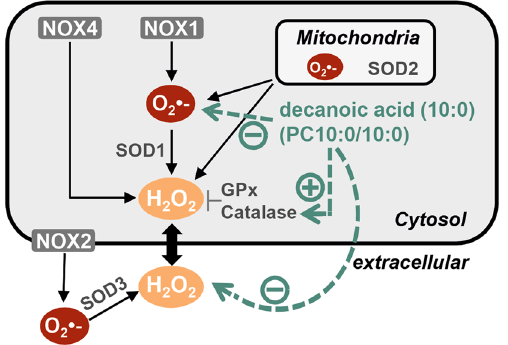
Figure 5. Schematic overview of the cellular generation and detoxification of O 2•− and H 2 O 2 including the observed effects of decanoic acid (10:0). The mitochondrial electron transport chain and NOX activity are the major cellular sources of O 2•− , which is rapidly converted to H 2 O 2 by distinct SODs (mitochondrial SOD2, cytosolic SOD1, extracellular SOD3). In contrast to other NOX isoenzymes generating O 2•− , NOX4 predominatly releases H 2 O 2. H 2 O 2 diffuses across cellular membranes and is intracellularly detoxified by antioxidant enzymes such as GPx and catalase. Decanoic acid (10:0) administered in the form of PC10:0/10:0 reduces the intracellullar ROS level with O 2•− probably representing the major detected ROS species. Additionally, the steady state level of extracellular H 2 O 2 as well as H 2 O 2 release is decreased in cells treated with PC10:0/10:0. The latter effect might be at least partially based on an upregulation of catalase activity independent of alterations in CAT gene expression. Figure was created using CorelDRAW Graphics Suite